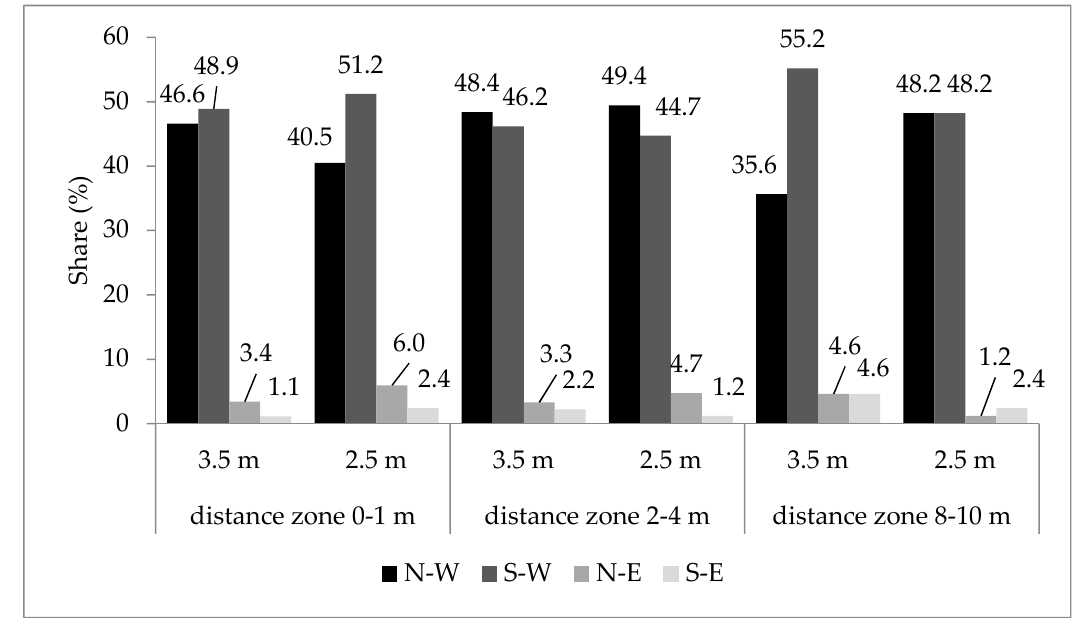
Figure 3. Stem pith shifts beside wider (3.5 m) and narrower (2.5 m) strip roads, showing movement in different directions (N-W, S-W, N-E, S-E) depending on the distance of trees from the strip